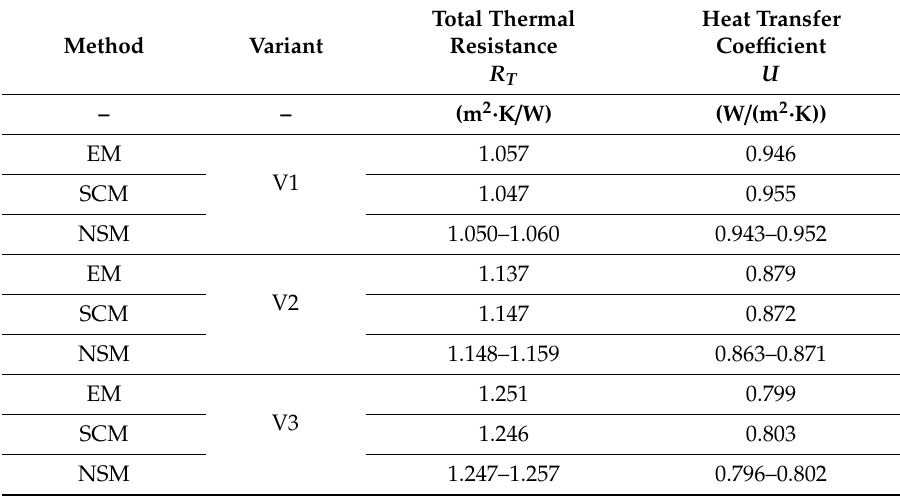
Table 6. Thermal parameters of the ceramic composite in all